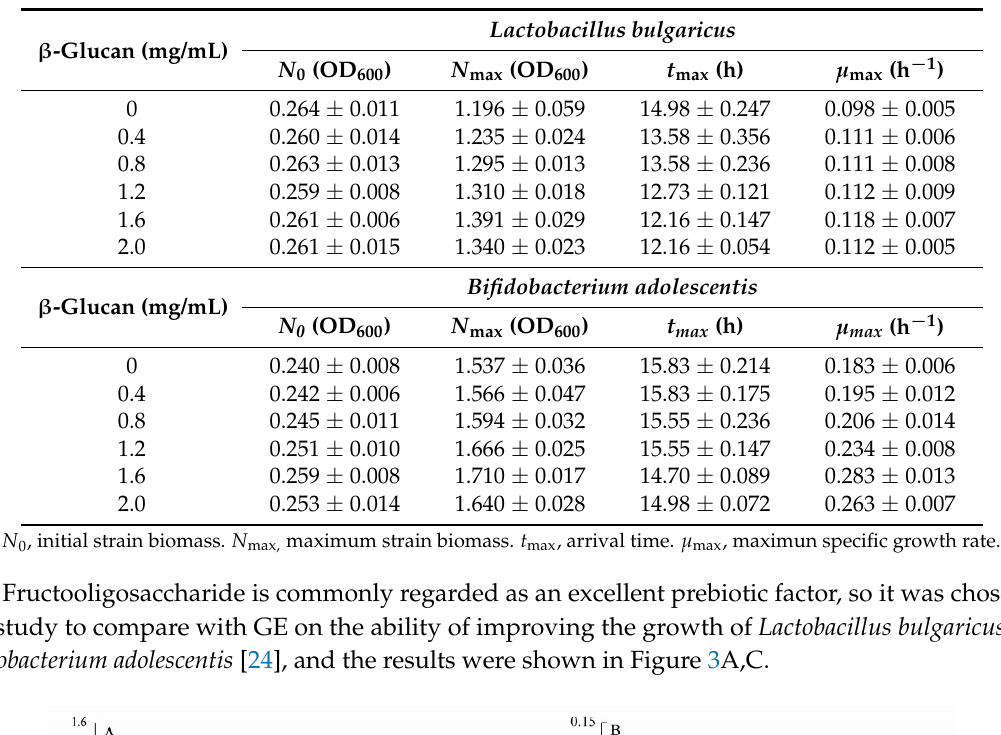
Table 3. Growth dynamic parameters of Lactobacillus bulgaricus and Bifidobacterium adolescentis.